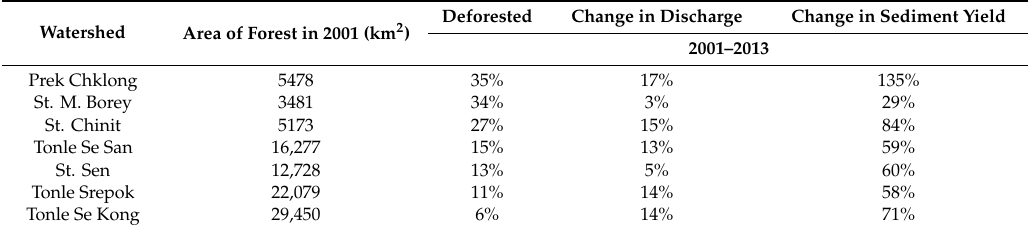
Table 4. Results for 7 different watersheds in Cambodia showing the area of forest in 2001, percent deforestation, and the resulting change in discharge and sediment between 2001 and 2013.